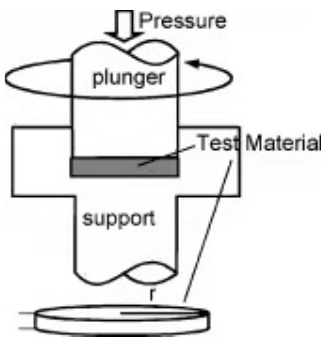
Figure 9. Schematic illustrations of the high-pressure torsion process reprinted from ref. [34]. Copyright 2022 ELSEVIER.